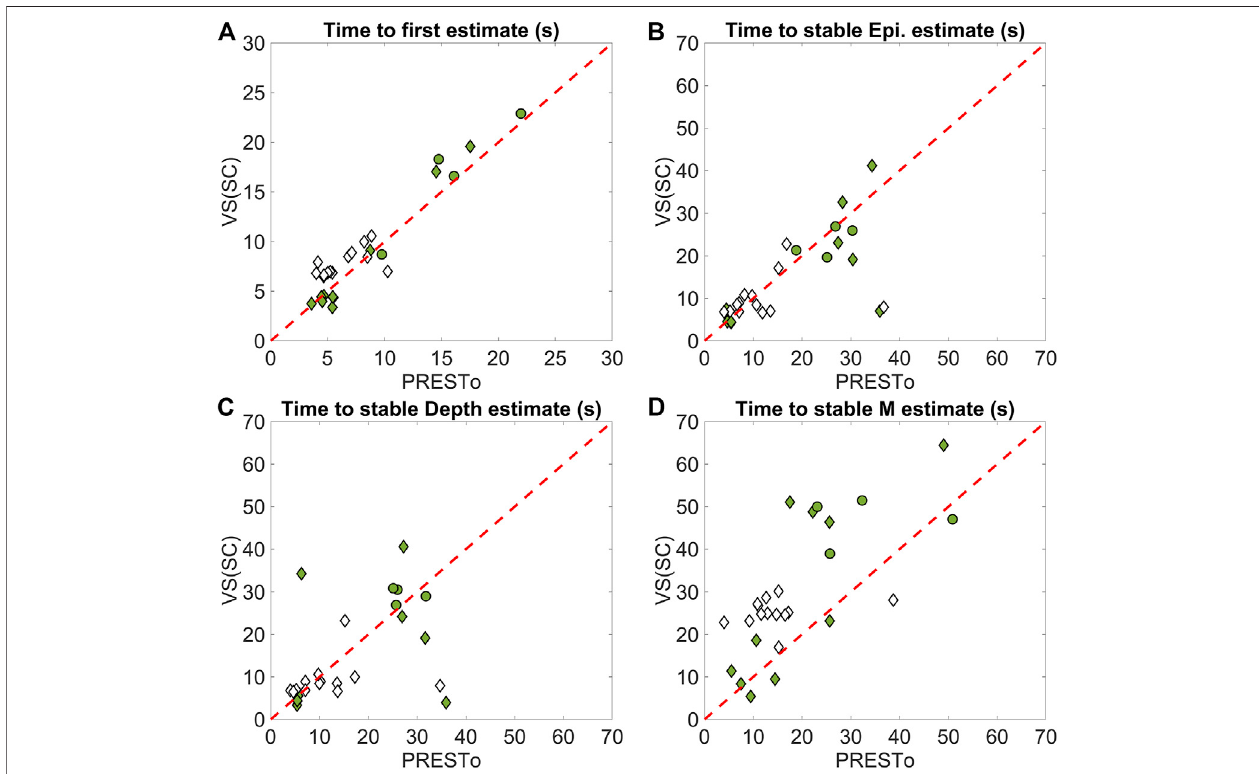
FIGURE5| ComparisonbetweenthePRESToandVS(SC)algorithmsintermsoftimeliness.TheaverageratiobetweenthetimesofPRESToandVS(SC)estimates is: (A) 0.94; (B) 1.3; (C) 1.5; and (D) 0.7. Note that times shown are relative to actual event times. Filled and empty markers indicate observed and simulated events, respectively. Diamond and circle markers indicate shallow and deep events,